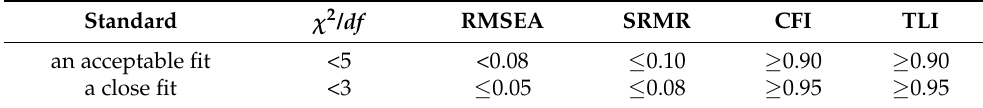
Table 1. The standard for five evaluation criteria of CFA. Standard χ 2 / df RMSEA SRMR